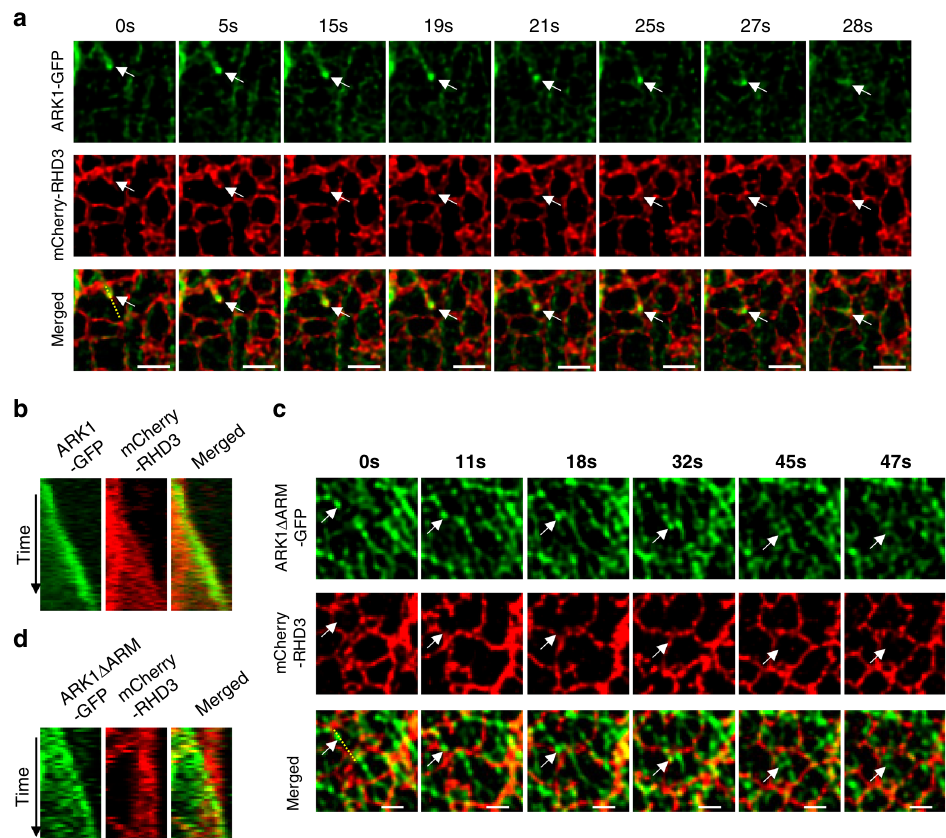
Fig. 9 ARK1 – GFP, but not ARK1 Δ ARM-GFP, co-moves with mCherry-RHD3 to pull an ER tubule toward another in an epidermal leaf cell. a The co- movement of an ARK1 – GFP comet/punctate (white arrows) together with mCherry-RHD3 along with the growth of an ER tubule during a time. The experiment was independently repeated nine times. Scale bars = 2 μ m. b A kymograph of the yellow line in ( a ) showing ARK1 – GFP is leading the growth of ER tubule. c The movement of an ARK1 Δ ARM-GFP comet (white arrows) in relation with mCherry-RHD3 during a time. This experiment was independently repeated four times. Scale bars = 2 μ m. d A kymograph of the yellow line in ( c ) showing the growth of ARK1 Δ ARM-GFP is not correlated with